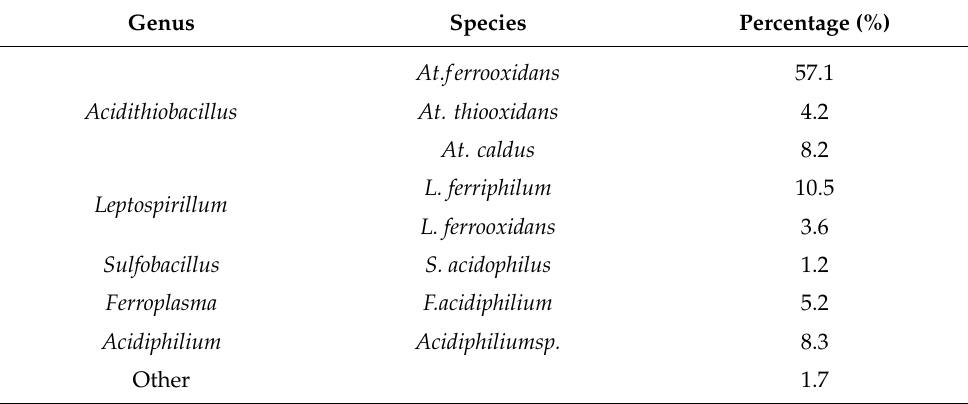
Figure 4. Microbes number in the leachate of cell P3C6. Table 3. Microbial community in heaps of cell P3C6 in May 2016.